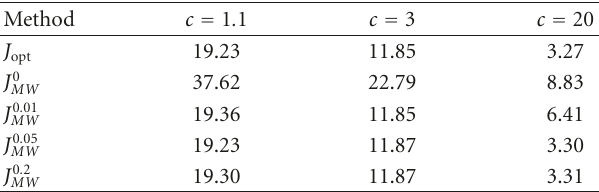
Table 7: Results of the MSE of the LSP for di ff erent parameter choices using Hermite functions as windows and a decreasing number of eigenvalues, N = 32 and F s =